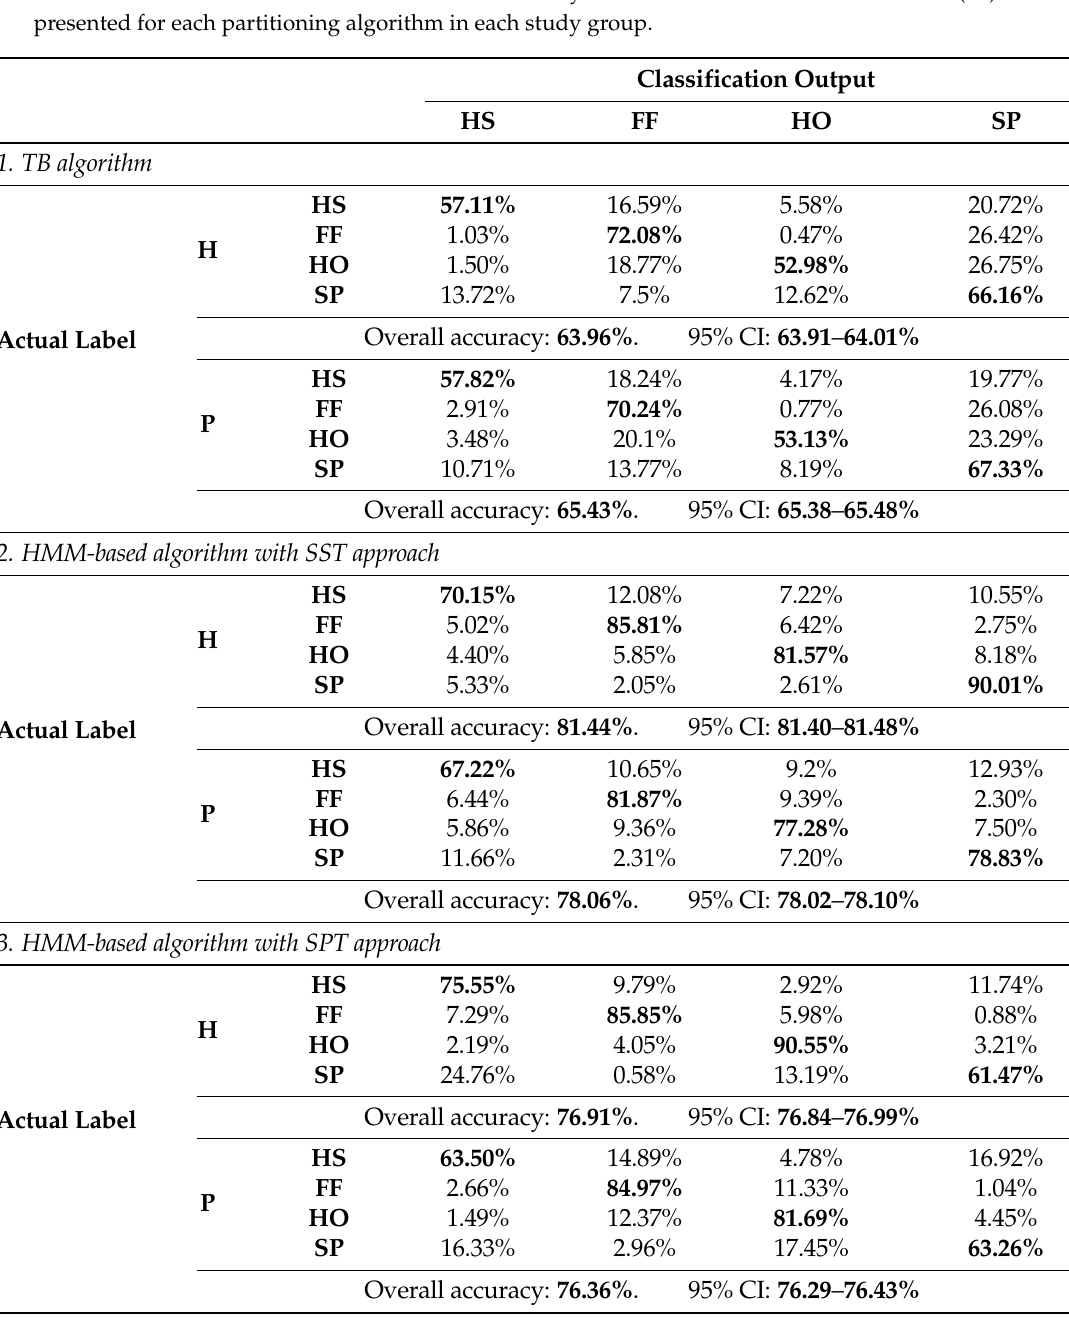
Table 5. Confusion matrices. Results are reported for each proposed classification method: (1) TB algorithm; (2) HMM-based method trained by means of an SST technique; and (3) HMM-based method trained by means of an SPT technique, for both healthy subjects (H group) and patients (P group). Correct classifications are in bold and overall accuracy values with 95% confidence interval (CI) are presented for each partitioning algorithm in each study